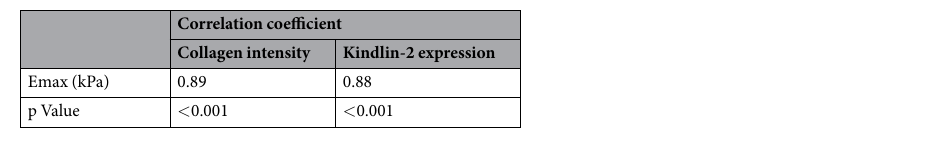
Table 3. Correlation of collagen intensity and Kindlin-2 expression with Emax of breast